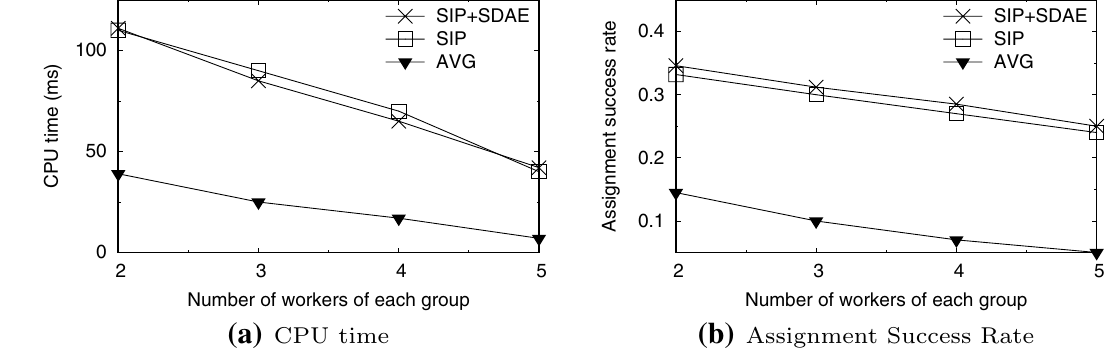
Fig. 6 Performance of preference modeling: effect of numW